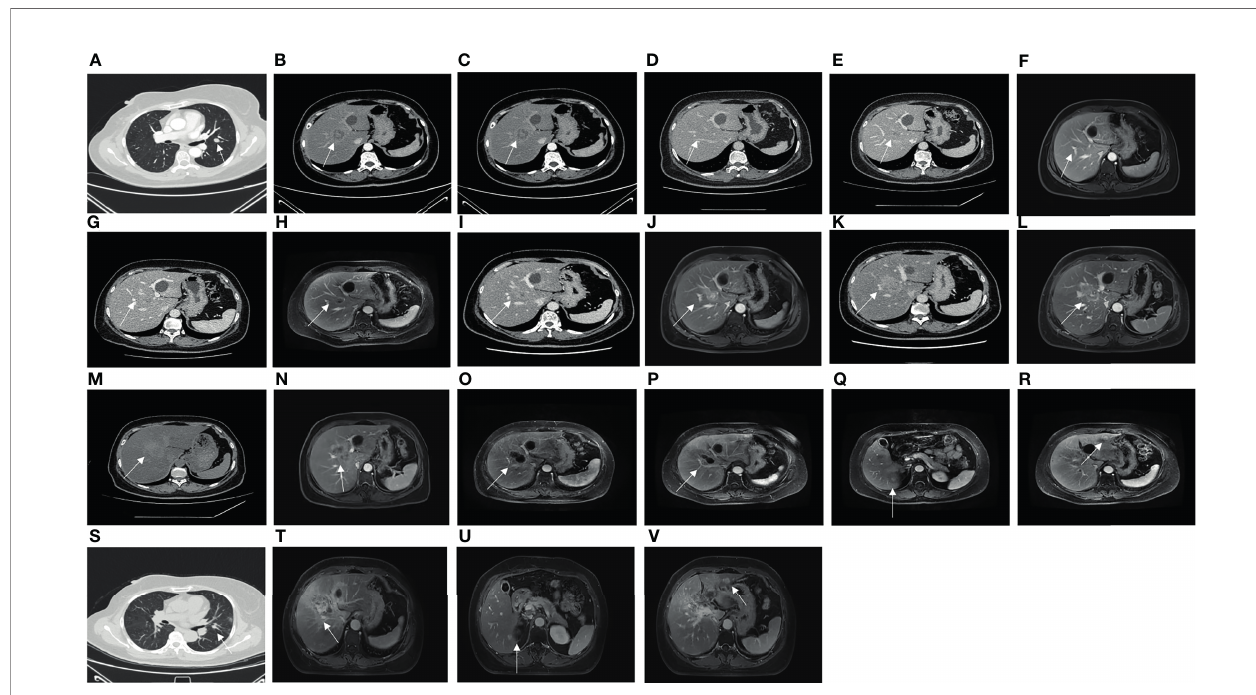
FIGURE 2 | On 2 May 2017, CT showed a pulmonary metastasis with a long diameter of 1.3 cm (A) . On 31 May 2017, CT showed a hepatic metastasis with a long diameter of 4.7 cm on the right anterior lobe (B) . On 30 October 2017, CT showed a hepatic metastasis with a long diameter of 2.0 cm before involved in a clinical trial of adjuvant endocrine therapy on the right anterior lobe (C) . On 30 August 2019, CT showed no apparent hepatic metastasis (D) . On 21 November 2019, CT showed a hepatic metastasis with a long diameter of 1.8 cm on the right anterior lobe (unclear boundary) (E) . On 25 November 2019, MRI showed a hepatic metastasis with a long diameter of 1.2 cm on the right anterior lobe (F) . On 15 June 2020, CT showed a hepatic metastasis with a long diameter of 1.5 cm on the right anterior lobe (G) , and MRI showed hepatic metastases, especially the biggest one with a long diameter of 2.7 cm on the right anterior lobe (H) . On 11 December 2020, CT showed a hepatic metastasis with a long diameter of 3.2 cm on the right anterior lobe (I) , and MRI showed a hepatic metastasis with a long diameter of 3.6 cm on the right anterior lobe (J) . On 26 February 2021, CT showed a hepatic metastasis with a long diameter of 3.2 cm on the right anterior lobe (K) , and MRI showed a hepatic metastasis with a long diameter of 4.4 cm on the right anterior lobe (L) . On 21 April 2021, CT showed a hepatic metastasis with a long diameter of 5.6 cm on the right anterior lobe (M) , and MRI showed a hepatic metastasis with a long diameter of 6.0 cm on the right anterior lobe (N) . On 6 August 2021, MRI showed a hepatic metastasis with a long diameter of 5.0 cm on the right anterior lobe (O) . On 9 October 2021, MRI showed a hepatic metastasis with a long diameter of 3.5 cm on the right anterior lobe (P) , a hepatic metastasis with a long diameter of 1.0 cm on the right posterior lobe (Q) , and a hepatic metastasis with a long diameter of 1 cm on the left lateral lobe (R) . On 21 October 2021, the last CT showed a pulmonary metastasis with a long diameter of 1.0 cm (S) . On 15 December 2021, MRI showed a hepatic metastasis with a long diameter of 6.7 cm on the right anterior lobe (T) , a hepatic metastasis with a long diameter of 1.0 cm on the right posterior lobe (U) , and a hepatic metastasis with a long diameter of 1 cm on the left lateral lobe (V)